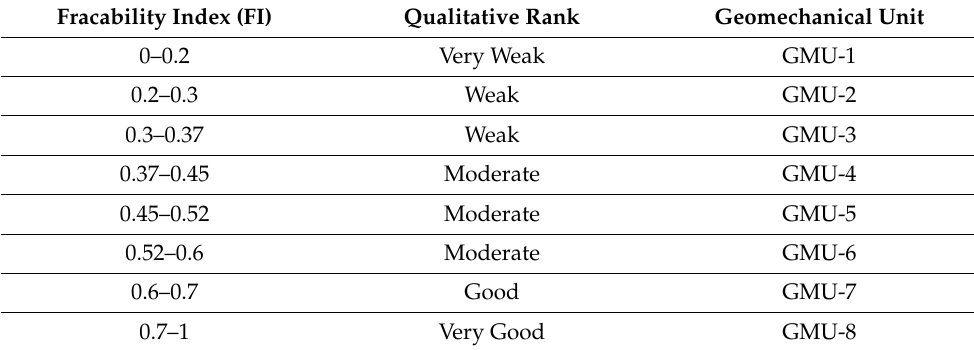
Tables of qualitative classification of layers based on three criteria indices: Table A1. Geomechanical units based on Total Fracability Index (TFI).